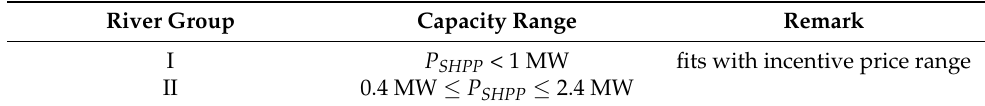
Table 2. River groups based on capacity